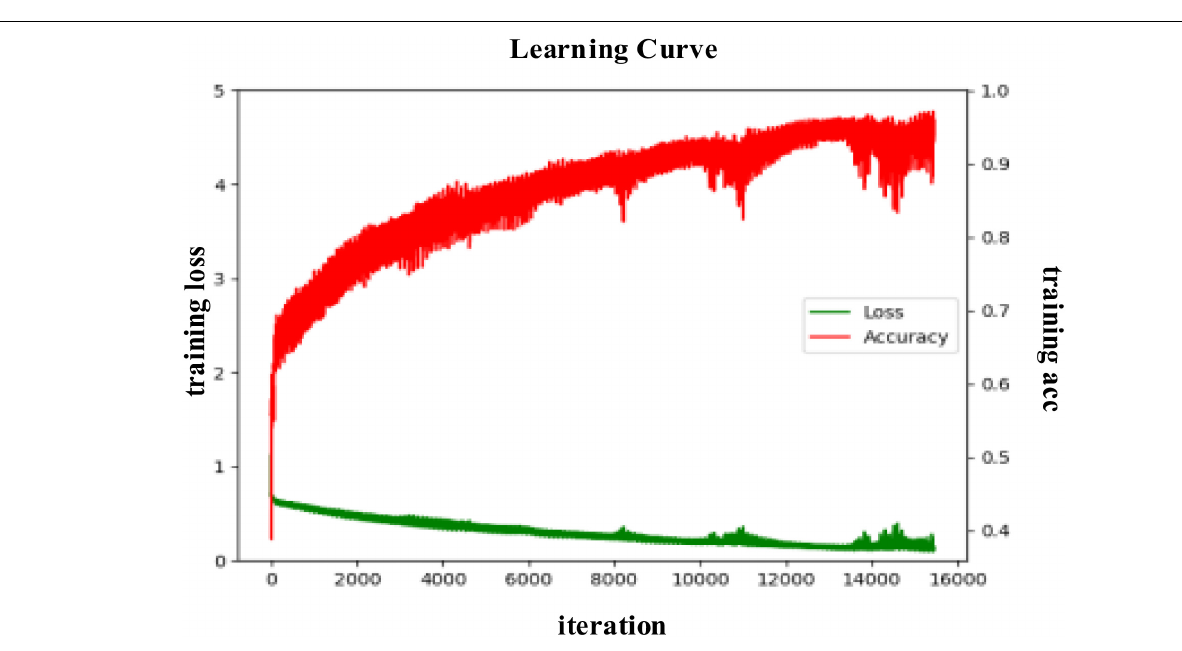
FIGURE 9 | The training process curve in the subject-independent experiment in